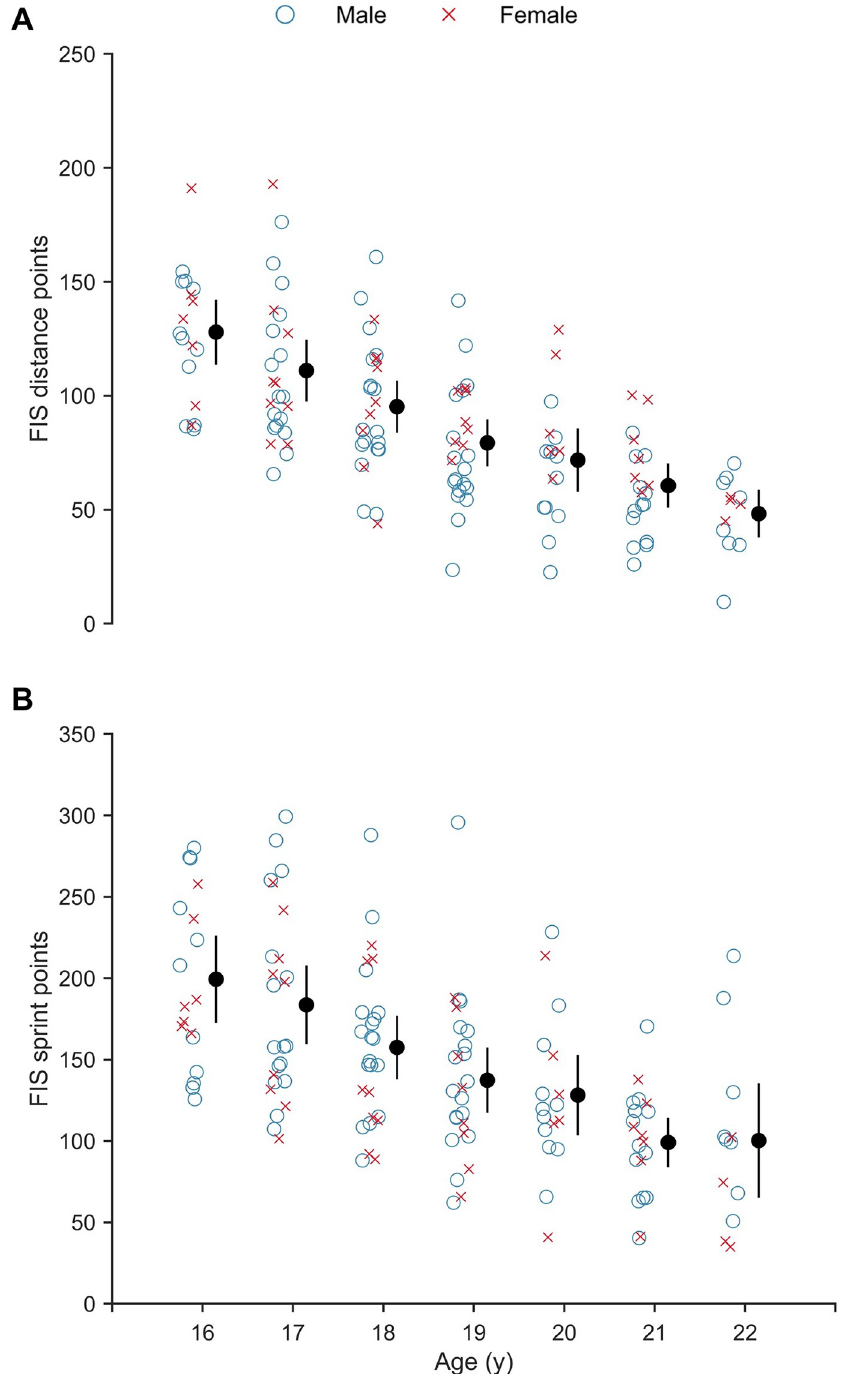
Fig 3. Progression in performance level from age 16 to 22 years (y) old represented by FIS points. (A) distance and (B) sprint competitions. Closed circles and whiskers: mean ± 95% CI.